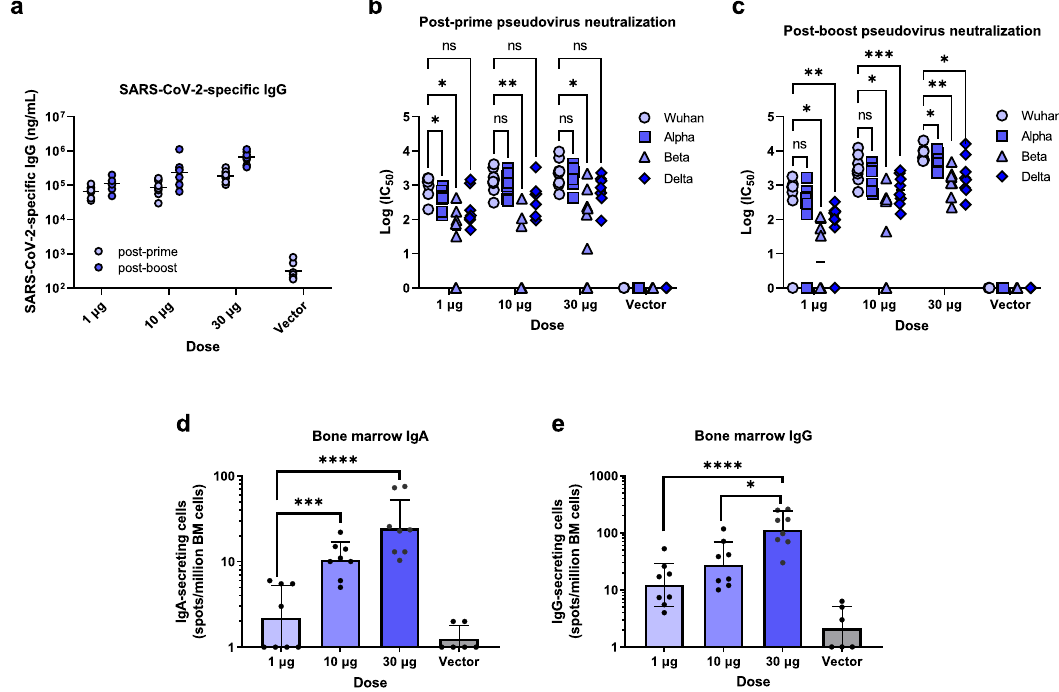
Fig. 4 Humoral immunogenicity pro fi les of optimized SARS-CoV-2 D614G-2P-3Q saRNA/NLC vaccine (AAHI-SC2) after prime or prime- boost immunization of C57BL/6 J mice. a Serum SARS-CoV-2 spike protein-binding IgG. Horizontal lines show geometric mean. Serum SARS- CoV-2 neutralizing antibody titers post-prime ( b ) and post-boost ( c ). Horizontal lines show geometric mean. Data were log-transformed and evaluated by mixed effects analysis with multiple comparisons. Induction of bone marrow (BM)-resident IgA- ( d ) and IgG-secreting ( e ) cells by ELISpot. Results show geometric mean and geometric standard deviation. Analyzed with one-way ANOVA with multiple comparisons. * p < 0.05, ** p < 0.01, *** p < 0.001, **** p < 0.0001. The vector control re p resents mice injected with 10 μ g of NLC-complexed saRNA expressing the non-immunogenic secreted embryonic alkaline phosphatase (SEAP) gene. n = 6 mice for SEAP control group and n = 8 for dosing